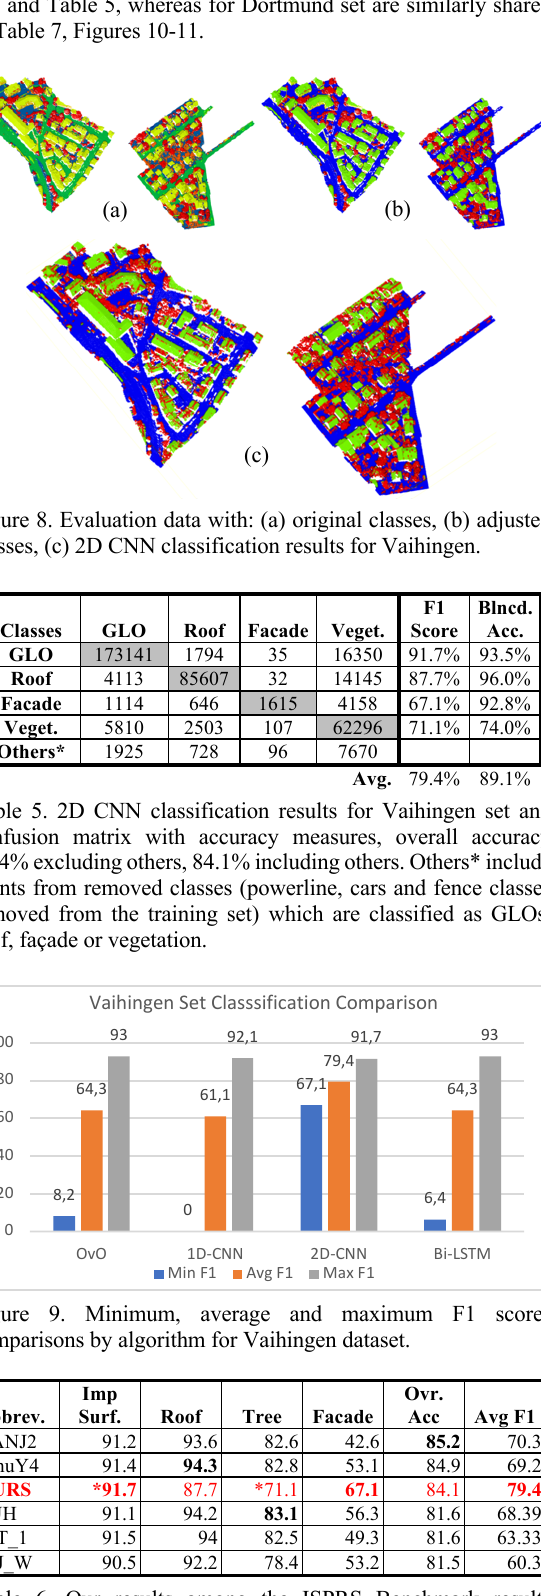
Table 6. Our results among the ISPRS Benchmark results (ISPRS, 2019).